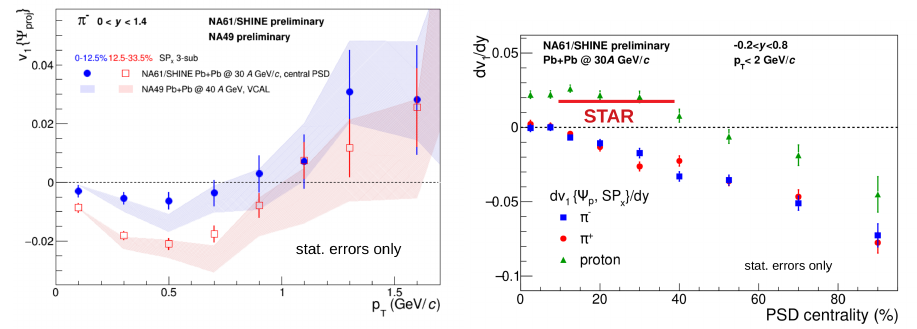
Figure 8. Left: Dependence of ν 1 on transverse momentum measured by NA61 / SHINE and NA49 [24] in Pb + Pb collisions at 30 A GeV / c. Right: Resolution of the correction factors R A PSD subgroups using 3-subevent method. For detials see text.